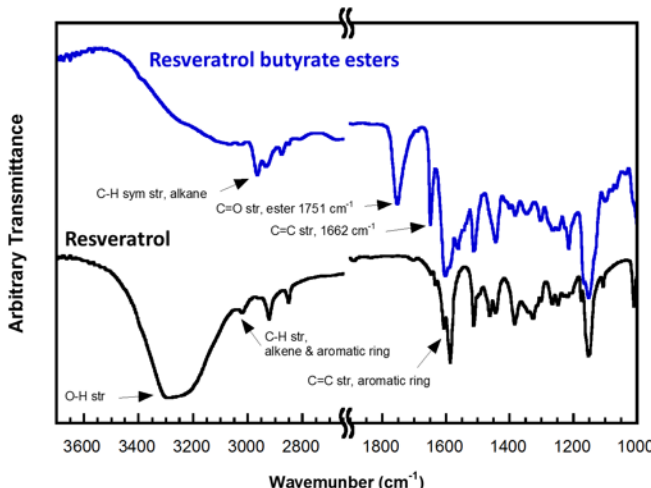
Figure 2. FTIR spectra of resveratrol and resveratrol butyrate esters.